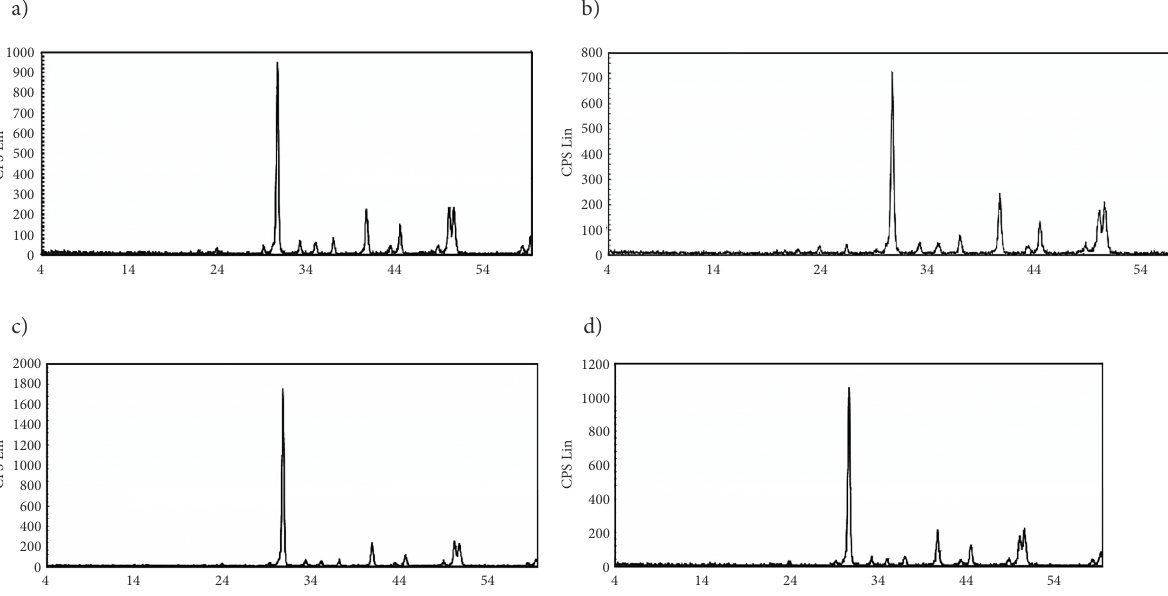
Figure 2. Results for dolomite samples studied by X-ray diffraction analysis (XRD): (a) Fine grain dolomite (Soltanieh Formation); (b) Fine grain dolomite (Elika Formation); (c) Medium grain dolomite (Soltanieh Formation); (d) Coarse Grain dolomite (Soltanieh